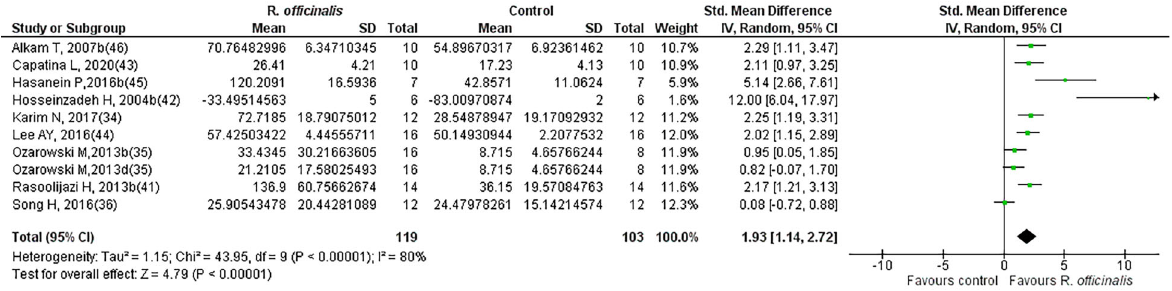
Figure 5. Forest plot of the effect of R. of fi cinalis on cognitive performance in cognitively impaired